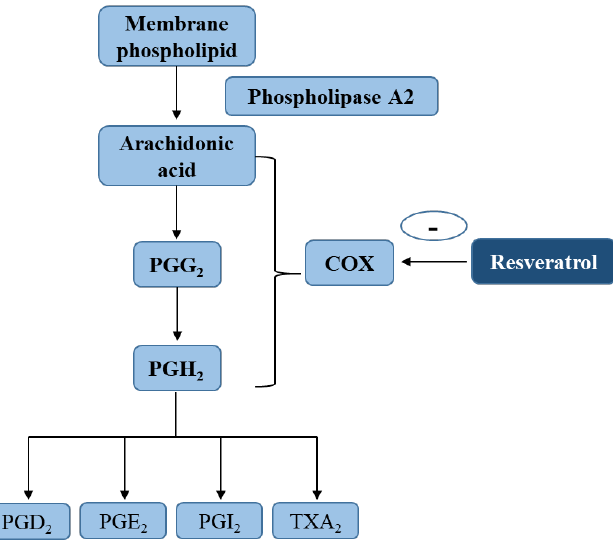
Figure 2. Inhibition of arachidonic acid metabolic pathway by resveratrol. Key abbreviations: COX, cyclooxygenase; PGD2, prostaglandin D2; PGE2, prostaglandin E2; PGI2, prostaglandin I2; TXA2, thromboxane A2.